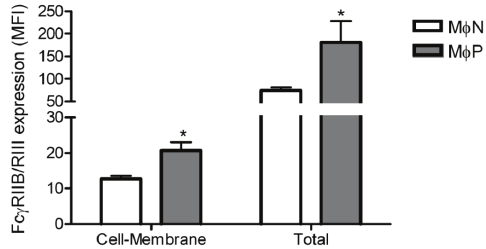
Figure 5. Total Fc γ RIIB/RIII protein in M φ N and M φ P. Cell-membrane and total Fc γ RIIB/RIII protein content were determined in non-permeabilized or permeabilized M φ N and M φ P cells. Fc γ RIIB/RIII expression was evaluated with 2.4G2 monoclonal antibody and analyzed by flow cytometry. Results are expressed as mean ± 1 SD from three independent experiments, using different passages of M φ N and M φ P.* indicates p <